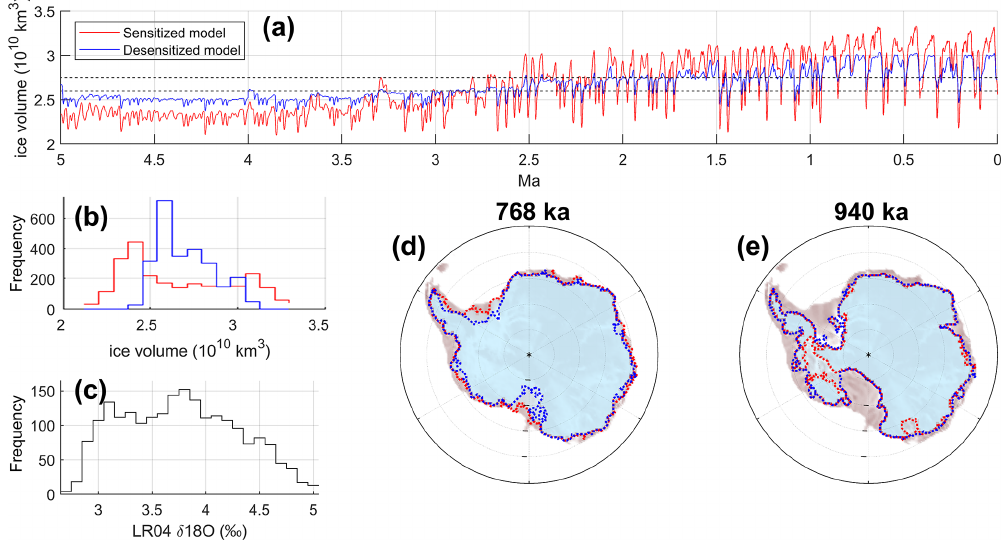
Figure 3. (a) Grounded ice volume throughout the Plio-Pleistocene produced by the sensitized (red) and desensitized (blue) simulations. Dashed lines represent the modern ice volume and an approximate WAIS collapse threshold, respectively. (b) Histogram of ice volume fluctuations shown in panel (a) . (c) Histogram of the δ 18 O time series (Lisiecki and Raymo, 2005) used to force the model simulations. (d, e) Snapshots of sensitized (red) vs. desensitized (blue) grounded ice configurations at two representative times; the sensitized ice sheet is bigger during glacials (d) and smaller during interglacials (e)